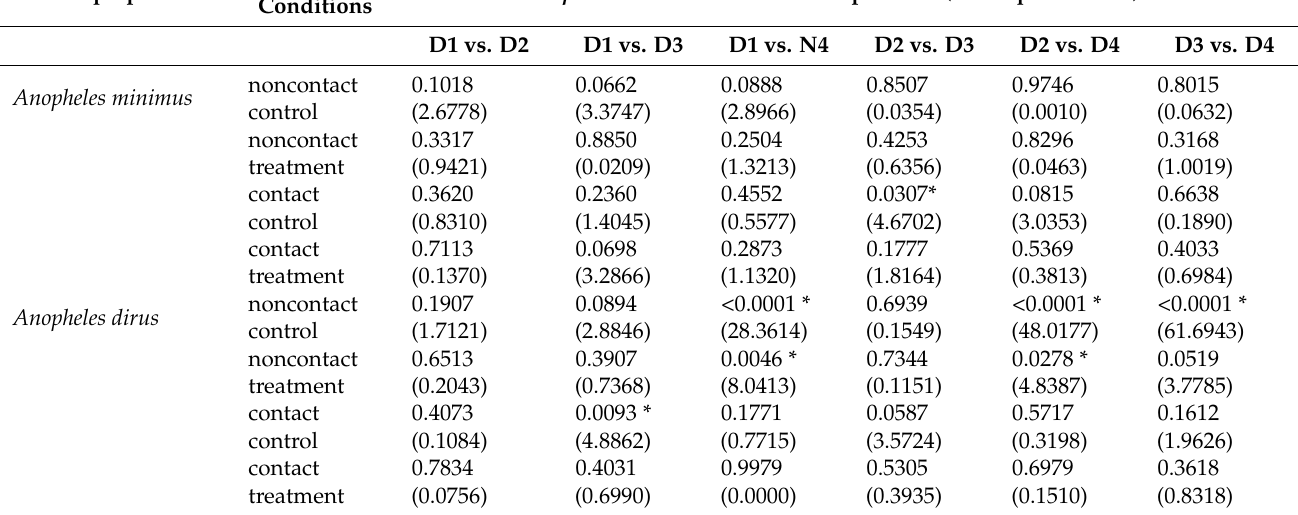
Table 4. Log-rank tests comparing diel quarterly time periods in daytime within species and treatments for Anopheles minimus and Anopheles dirus .